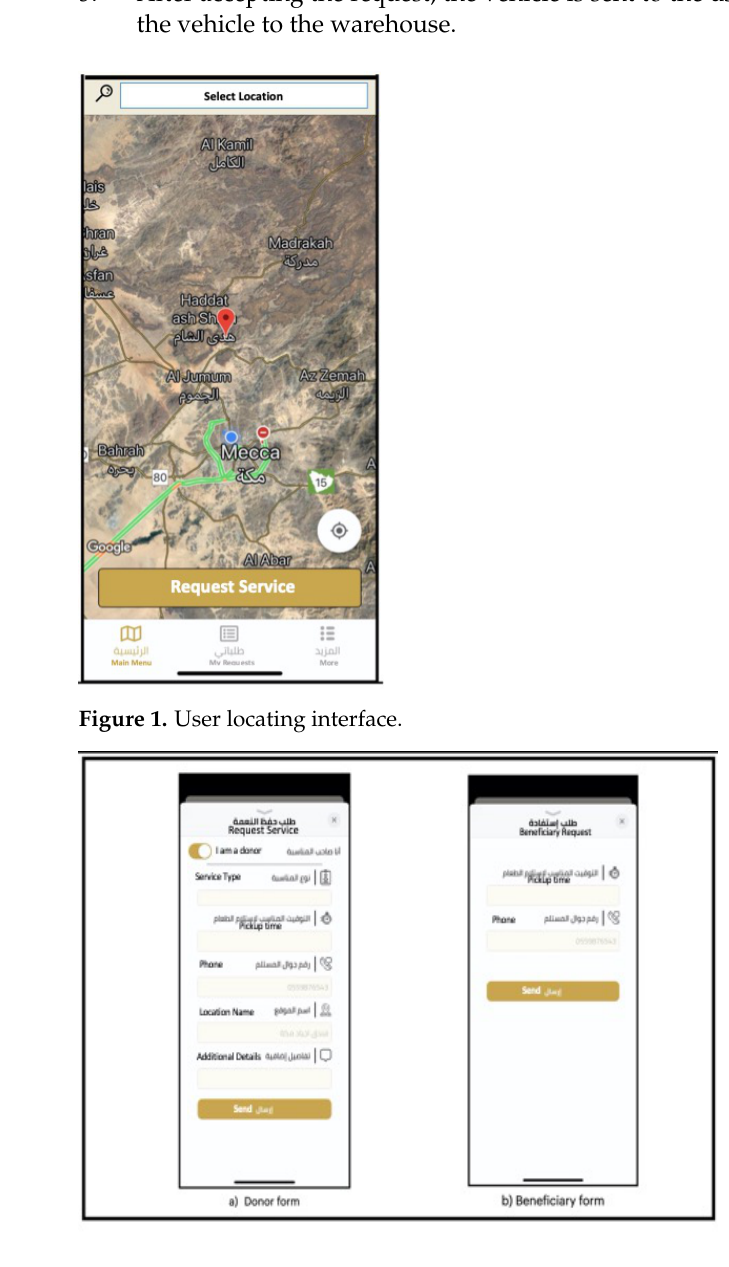
Figure 2. Donor and beneficiary form to complete request with